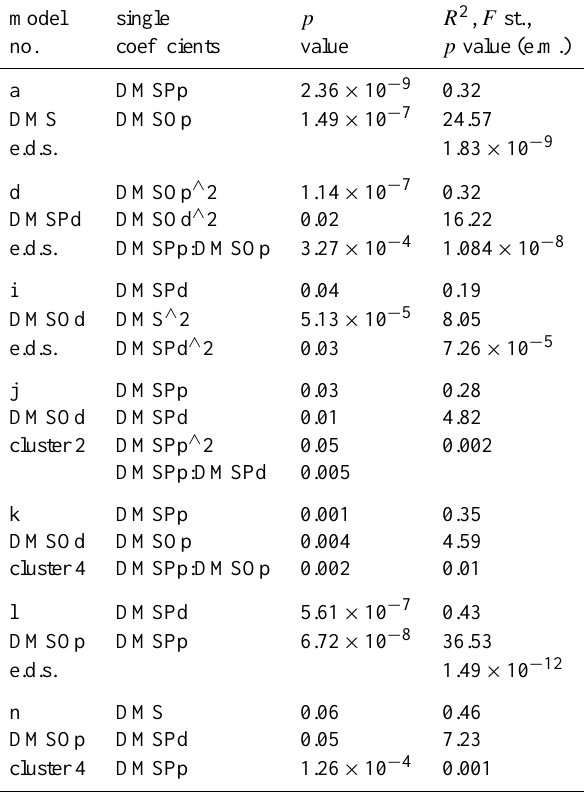
Table 2. Significant multiple linear regressions between DMS, DMSP and DMSO (d=dissolved, p=particulate, t=total) for the entire data set and within the clusters 2 and 4. Single coefficients and p values of each multiple linear regression model as well as R 2 , F statistic and p value of each entire model are given. The response variable is given under the model number. The independent variable squared shows a quadratic relationship to the response variable. The complete output of all models is given in the Supplement (the data presented here is extracted from Table 1 in the